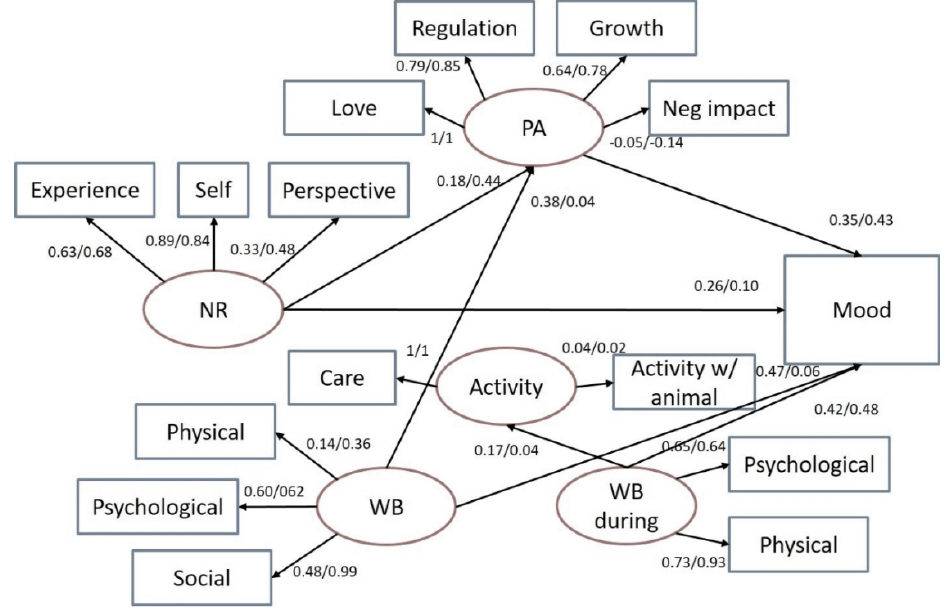
Figure 2. Structural equation model, standardized coefficients for riders/dog owners with latent variables in ellipses and observed variables in rectangles.